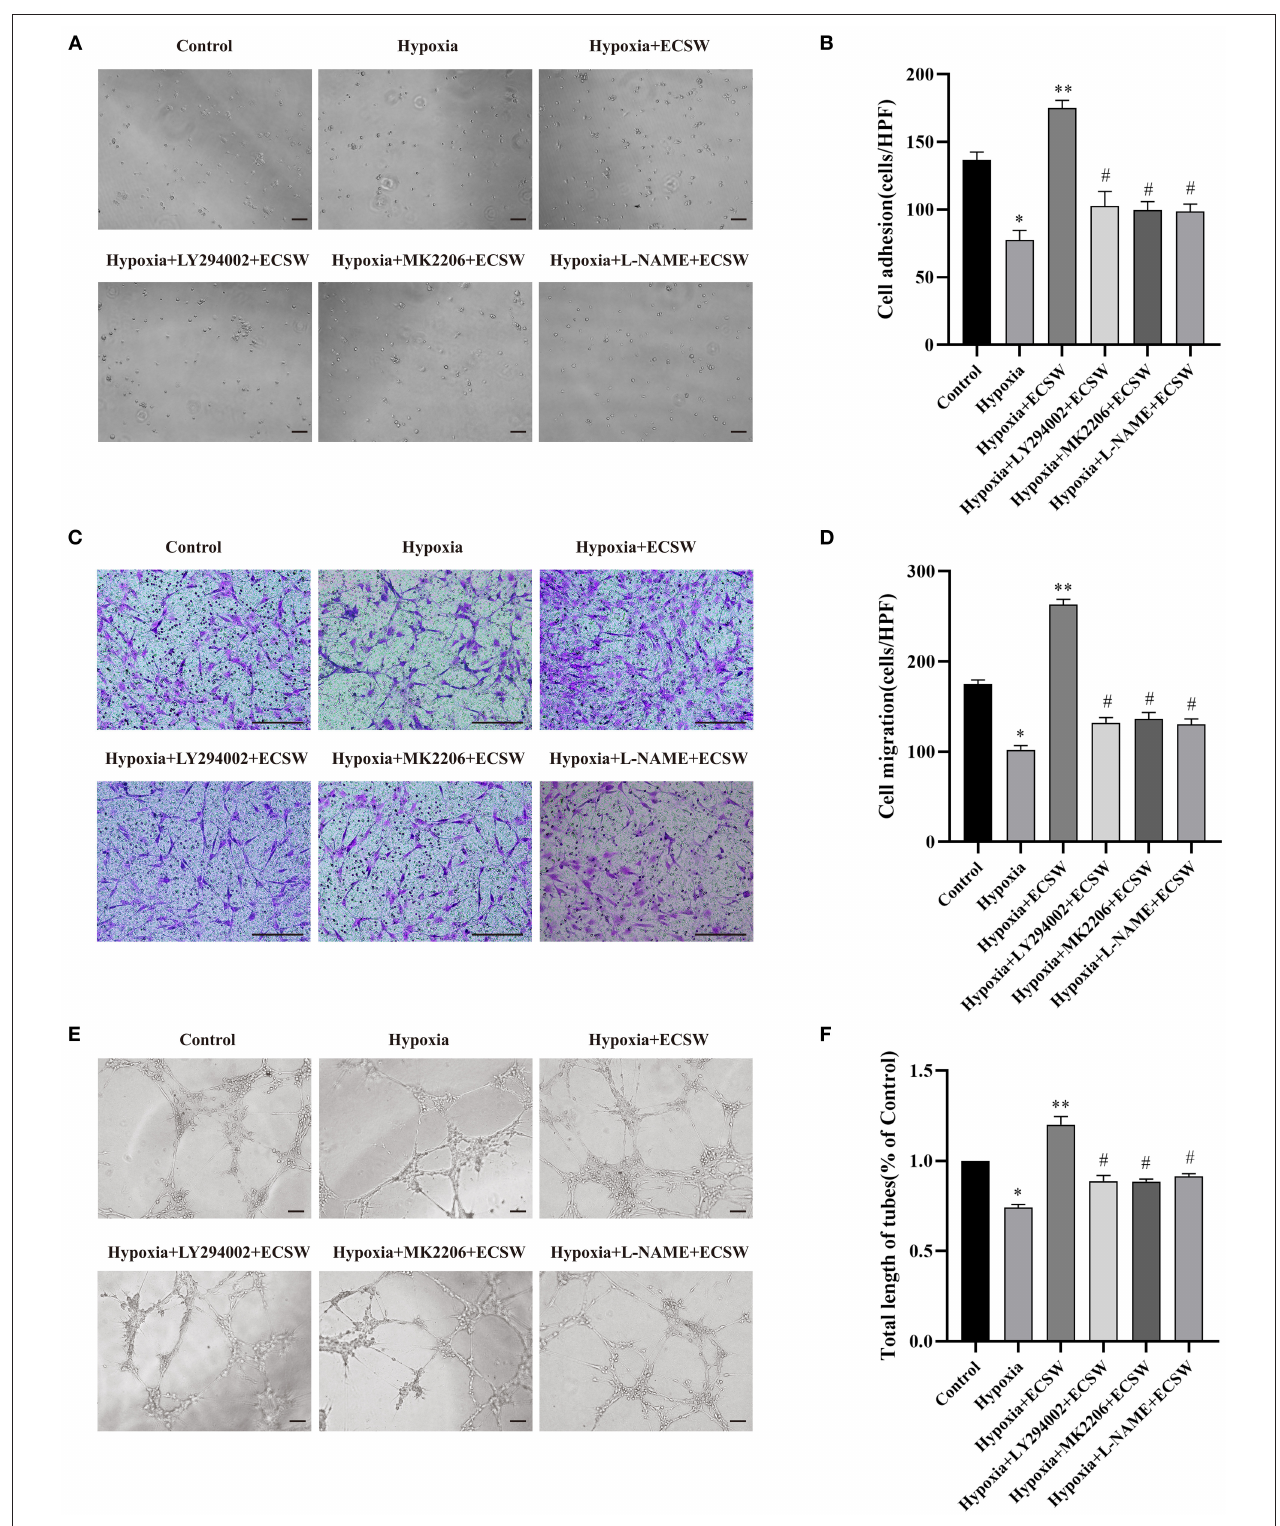
FIGURE 4 | ECSW improve the adhesive, migratory, and tube formation capacity of EPCs after hypoxic injury by activating PI3K/Akt/eNOS signaling pathway. (A,C,E) Representative images of EPCs adhesive, migratory, and tube formation in each group under a microscope. (A,E) Scale bar = 100 µ m; (C) Scale bar = 200 µ m. (B,D,F) Quantitative analysis of the adhesive, migratory, and tube formation of EPCs in each group. Data are presented as mean ± SD, N = 3. * P < 0.05 vs. group control, ** P < 0.05 vs. group hypoxia, # P < 0.05 vs. group hypoxia + ECSW.